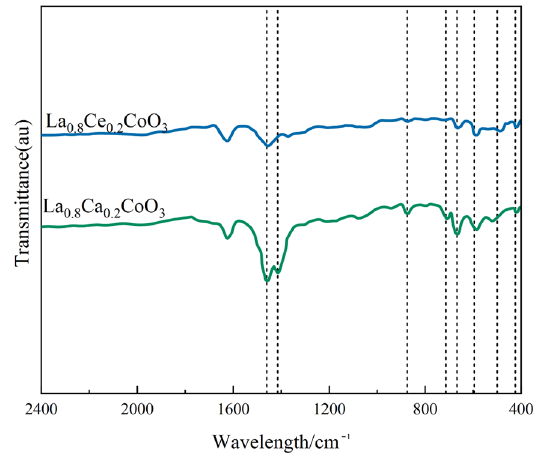
Figure 6. FTIR spectra of La 0.8 Ce 0.2 CoO 3 and La 0.8 Ca 0.2 CoO 3 catalyst samples.